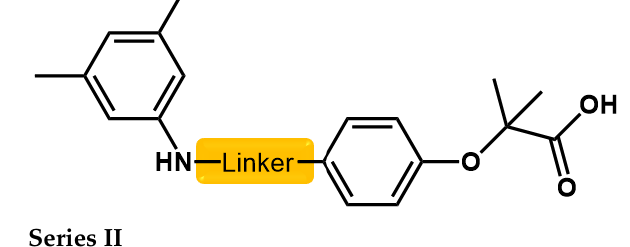
Red blood cell analyses were carried out at a final effector concentration of 2 mM. All stock solutions were prepared in DMSO at a concentration of 200 mM. P 50 represents the partial pressure of oxygen when 50% hemoglobin is saturated in the presence of effectors. P 50 C is the control value of P 50 in the presence of 1% DMSO. ∆P 50 = (P 50 – P 50 C) in mmHg. K is the Hill coefficient of the oxygen dissociation curve when the red blood cells are 50% saturated. Data are displayed as mean ± SD.